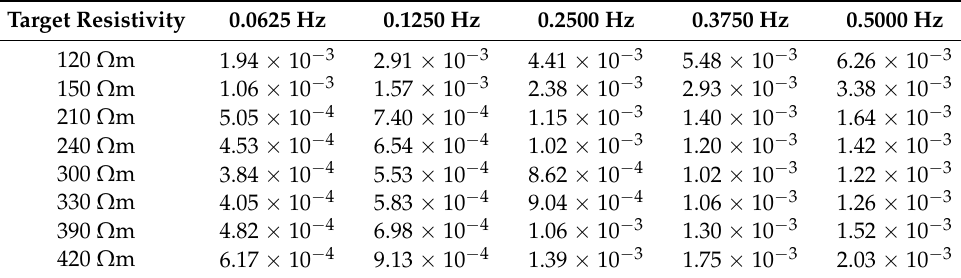
Table 3. Root mean squared deviation (RMSD)